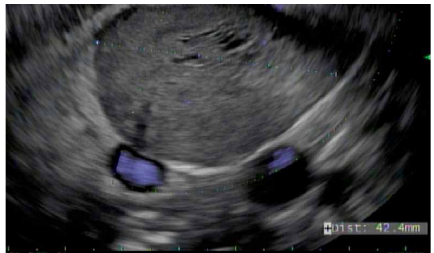
Figure 2: Endoscopic Ultrasound (EUS) examination demonstrated an oval, hypoechoic mass with well-defined borders and no evidence of associated regional lymphadenopathy. No invasion of regional vasculature was present.